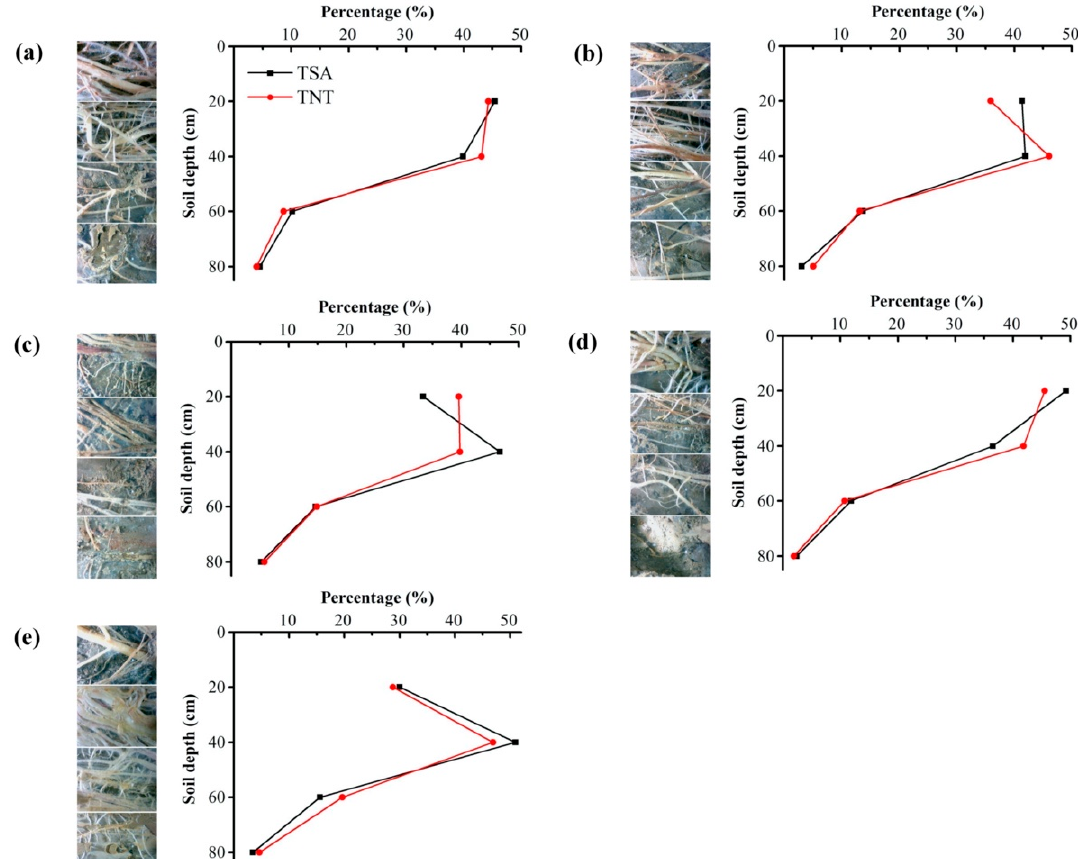
Figure 3. The summer maize roots at mature stage. ( a ) DFAA1 treatment; ( b ) DFAA2 treatment; ( c ) DFAA3 treatment; ( d ) DFAA4 treatment; ( e ) CK treatment. The photos in the left of each figure are the roots growing in the corresponding depths. TSA represents the total root surface area; TNT represents the total number of root tips.